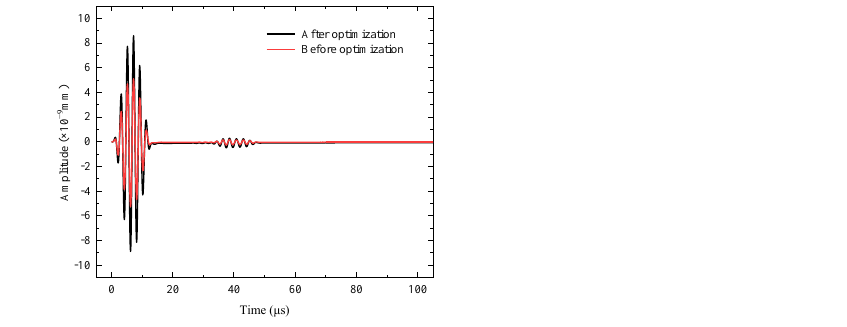
Figure 22. Time domain comparison of received signals before and after optimization.